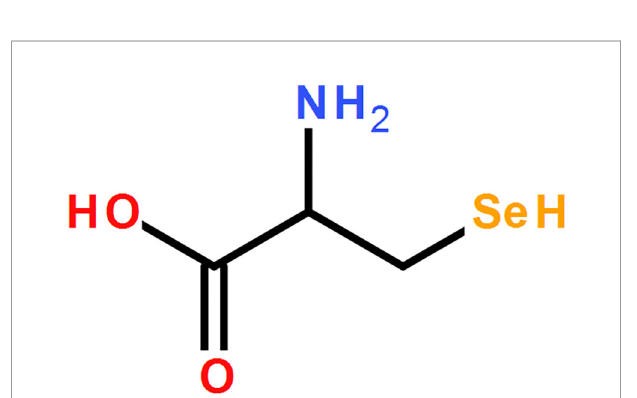
FIGURE 7 | The schematic structure of Selenocysteine.